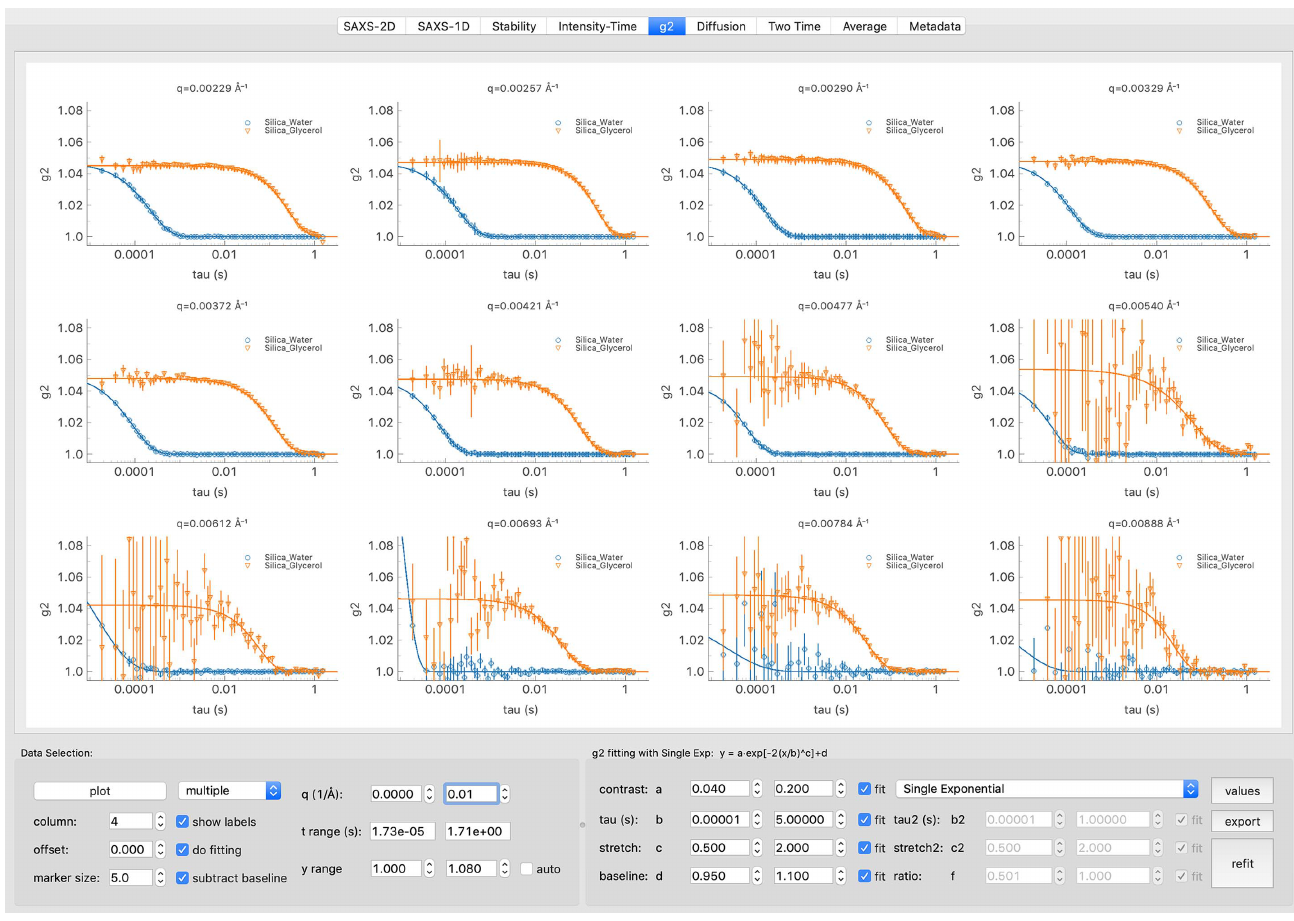
Figure 4 Multi-tau visualization and modeling. Users can customize the plot ranges, offset and the layout. Two widely used fitting models are included. Additional details about this module can be found in the